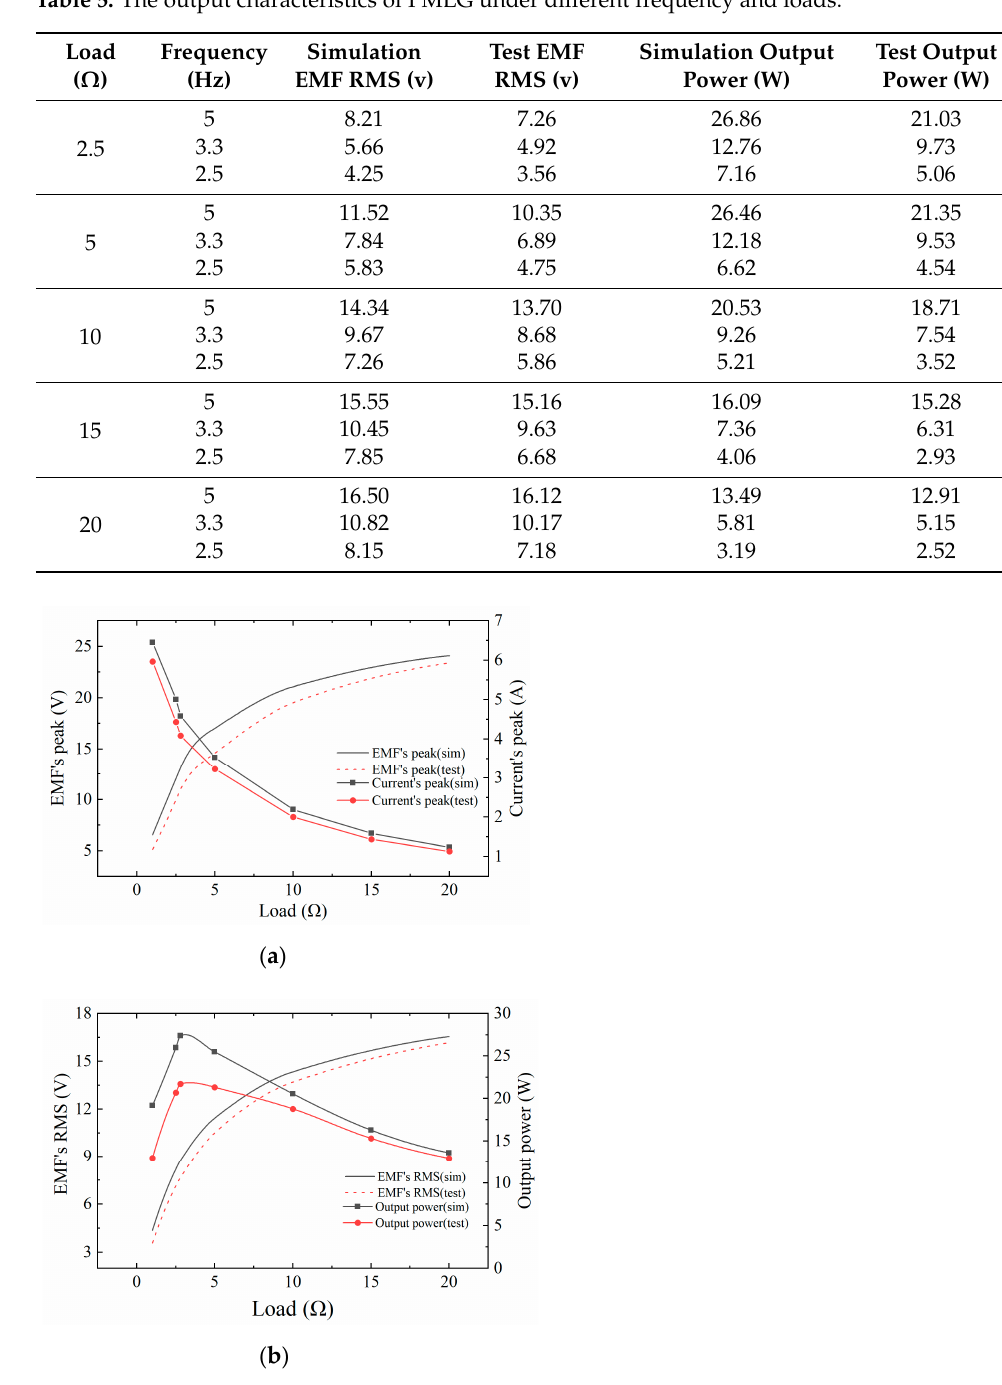
Figure 15. Output performance of simulation and test. ( a ) Output EMF and current; ( b ) output EMF and power.